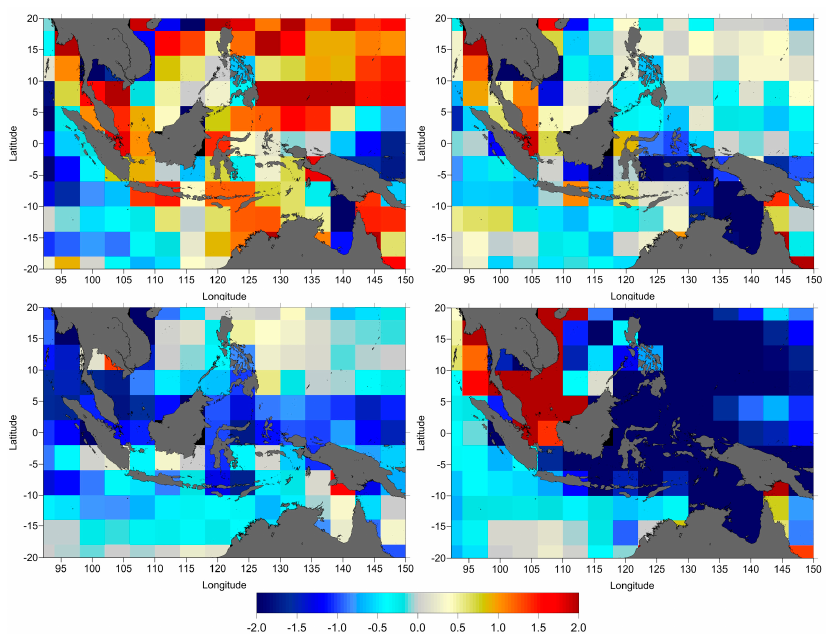
Figure 11. Along-track SLA variance differences (cm 2 ), Top panels: between Sea State Bias Non-Parametric CLS and Sea State Bias Parametric BM4 for TOPEX (( left ) TOPEX-A cycles 1 to 235; ( right ) TOPEX-B cycles 236 to 264); Bottom panels: corresponding differences between Sea State Bias Non-Parametric Tran2012 and CLS SSB models for Jason-1 cycles 1 to 259 ( left ) and Jason-2 cycles 1 to 280 ( right ). Remote Sens. 2017 , 9 , 102 16 of 31